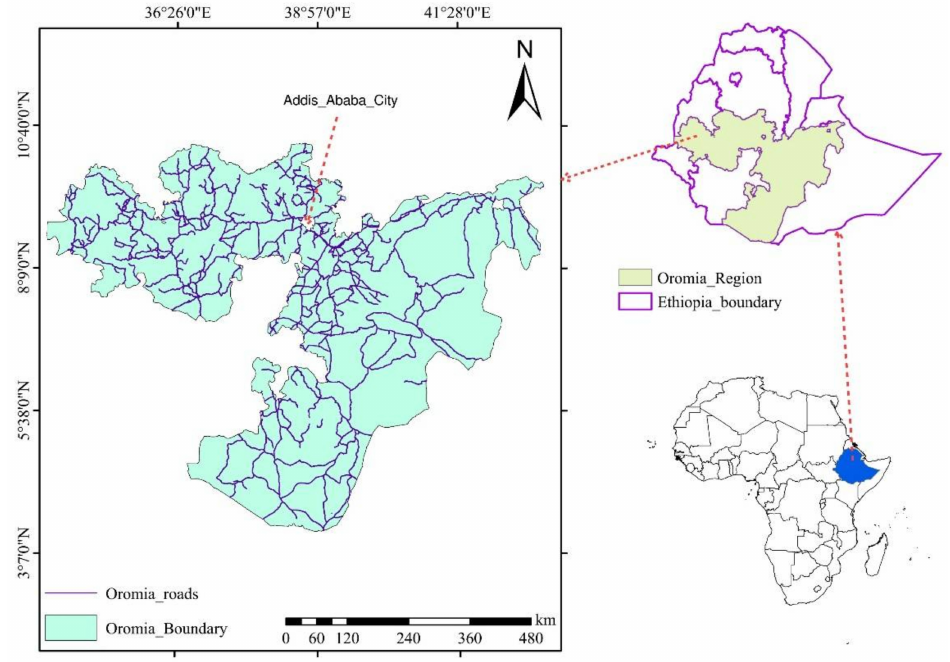
Figure 1. Map of the study area in